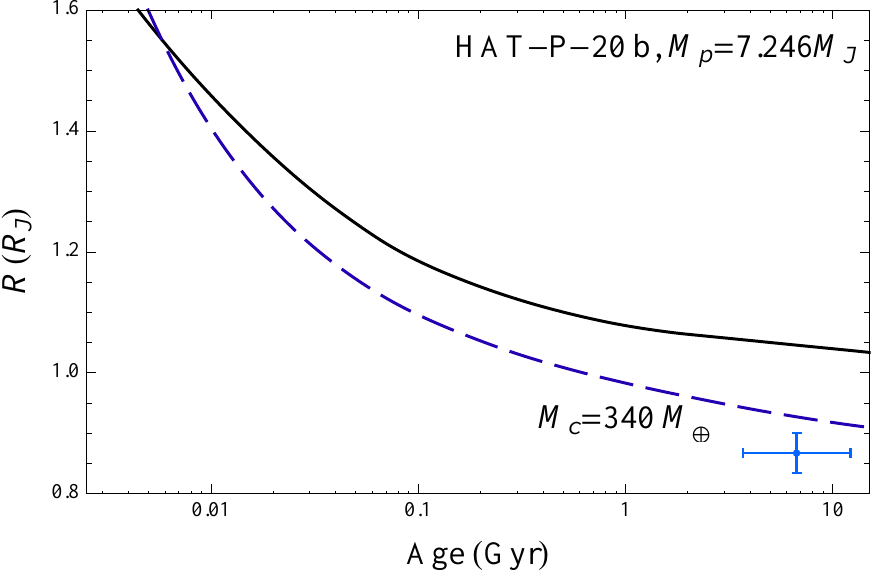
Figure 2: Radius evolution of a 7.2 M J planet model with solar composition (Solid) and with a 340 M ⊕ water core (Dashed) compared with the 1 σ error